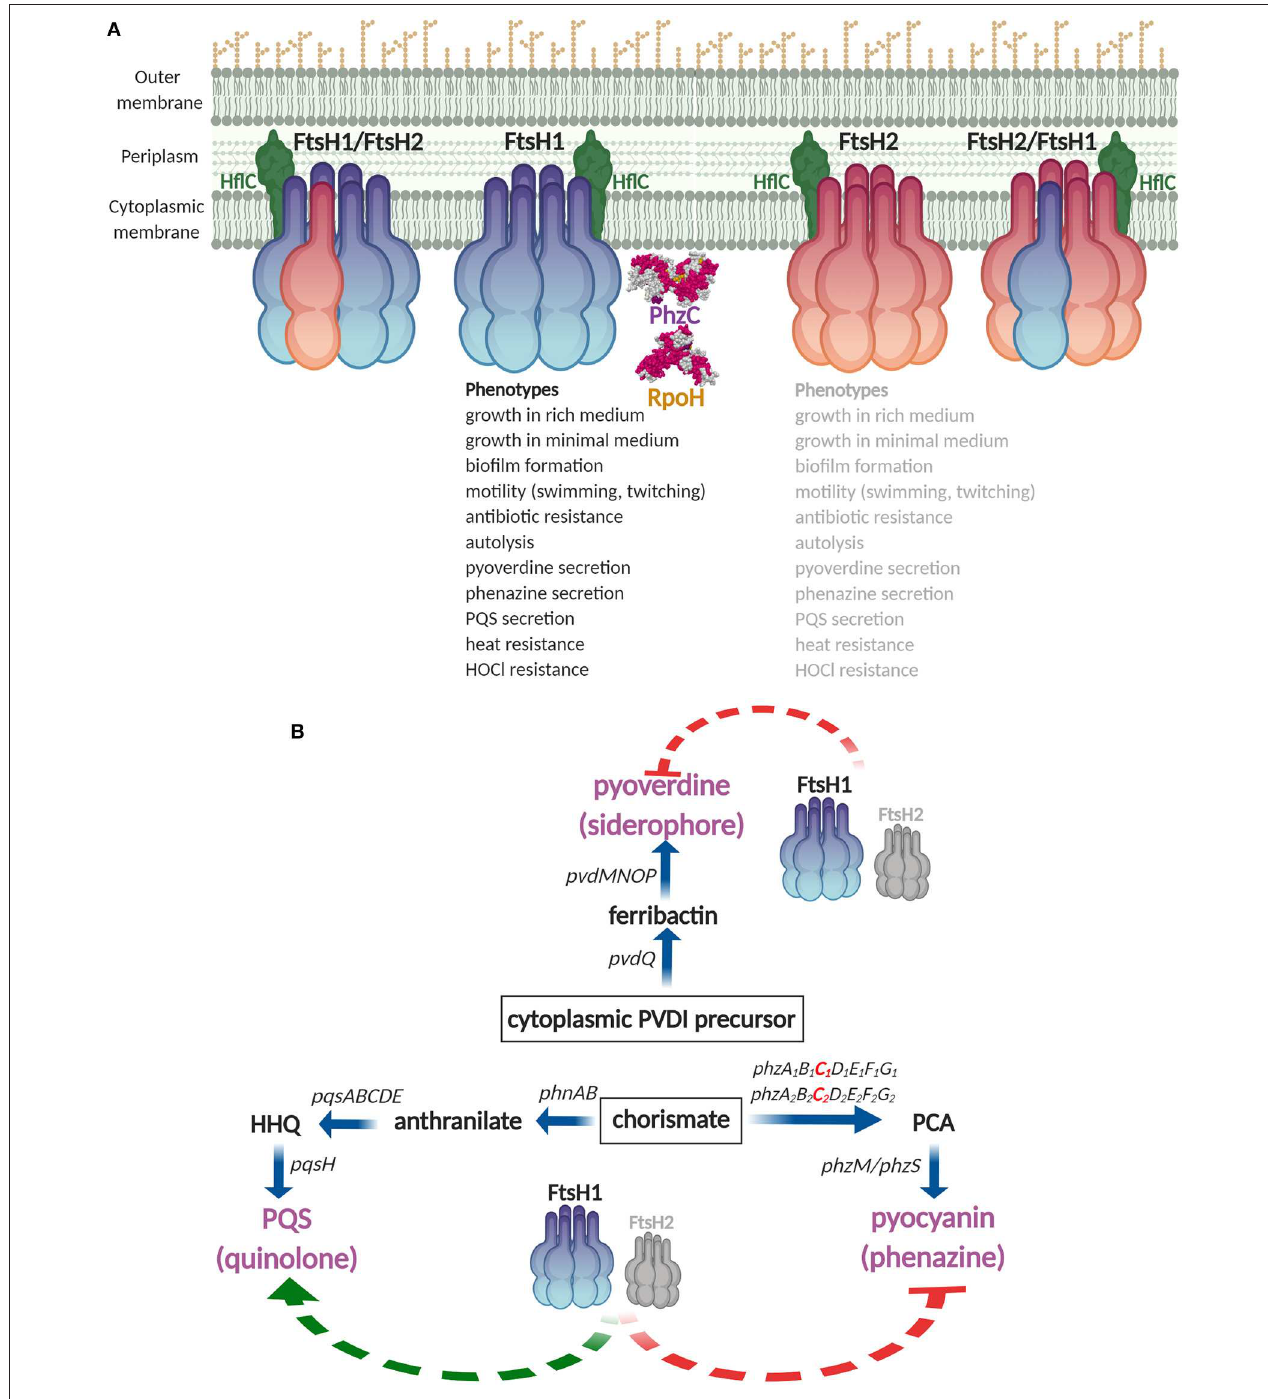
FIGURE 7 | Summary diagram of FtsH1 and FtsH2 functionality in P. aeruginosa SG17M. (A) FtsH anchored to the inner cell membrane as homo- and hetero-oligomers are represented by different color codes for monomers. Phenotypes are affected by FtsH1 (listed in black), with back-up contribution of FtsH2 (listed in gray). FtsH1/FtsH2 associated membrane protein HflC and confirmed substrates, RpoH and PhzC, are indicated. RpoH and PhzC structure models are obtained from PDB entry 1SIG (Narberhaus and Balsiger, 2003) and 6BMC (Sterritt et al., 2018), respectively. (B) FtsH1 and FtsH2 act as major regulators of secondary metabolites by affecting the secretion of pyoverdine, pyocyanin, and Pseudomonas quinolone signal PQS. HHQ, PQS intermediate 2-heptyl-4-quinolone; PCA, phenazine intermediate phenazine-1-carboxylic acid. Figure created with BioRender.